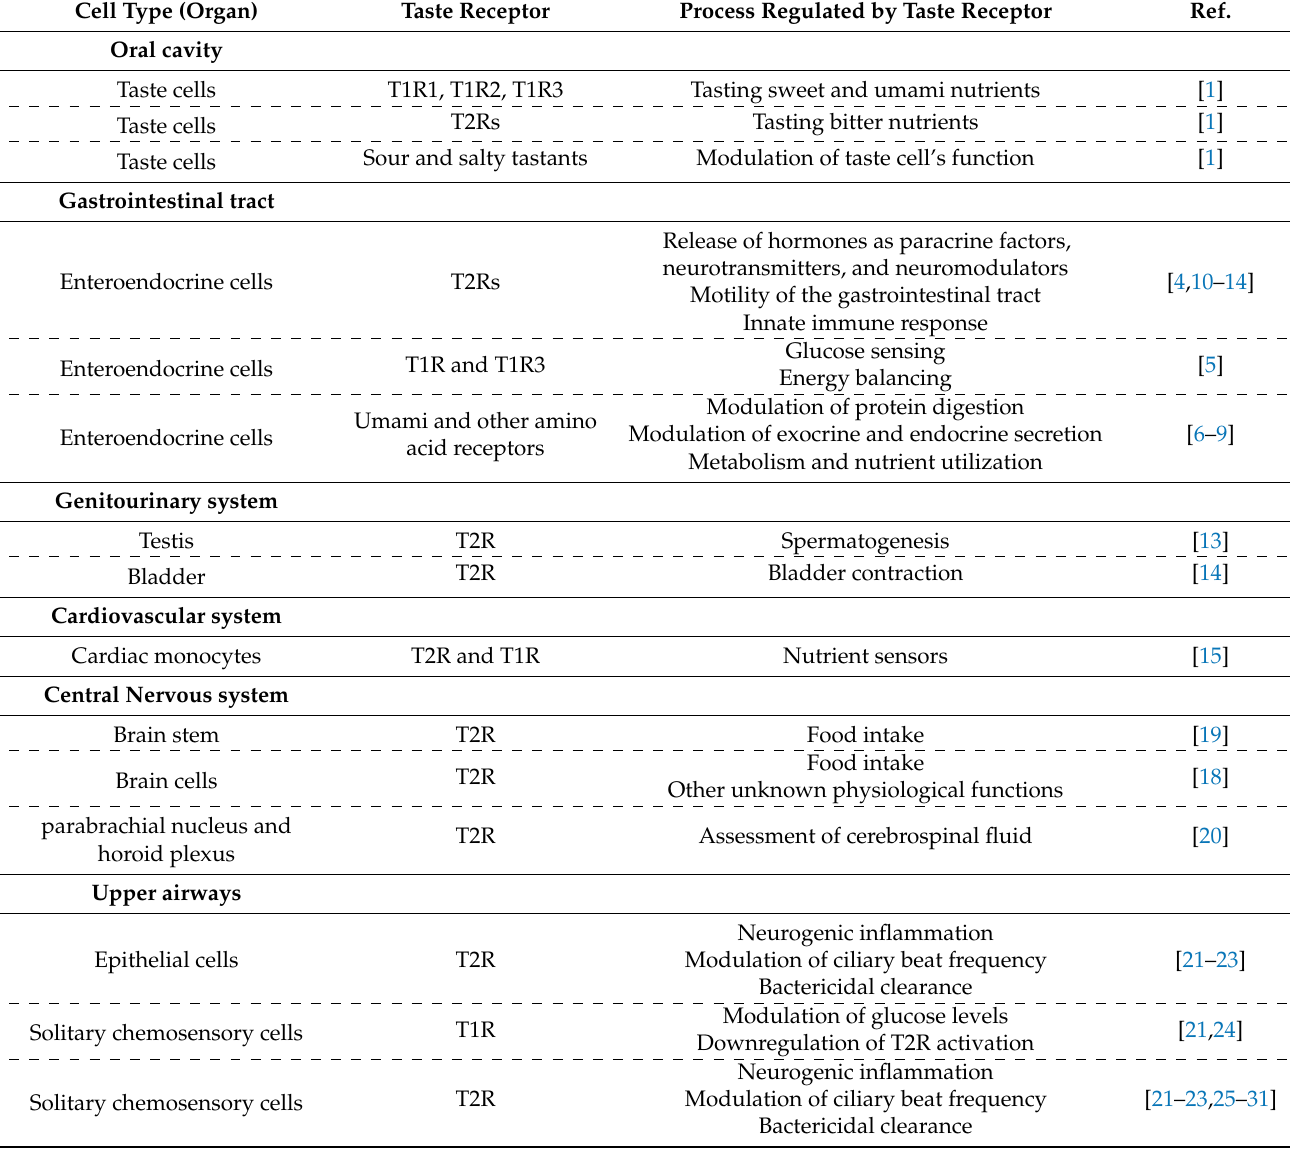
Table 1. Taste receptor expression throughout the human